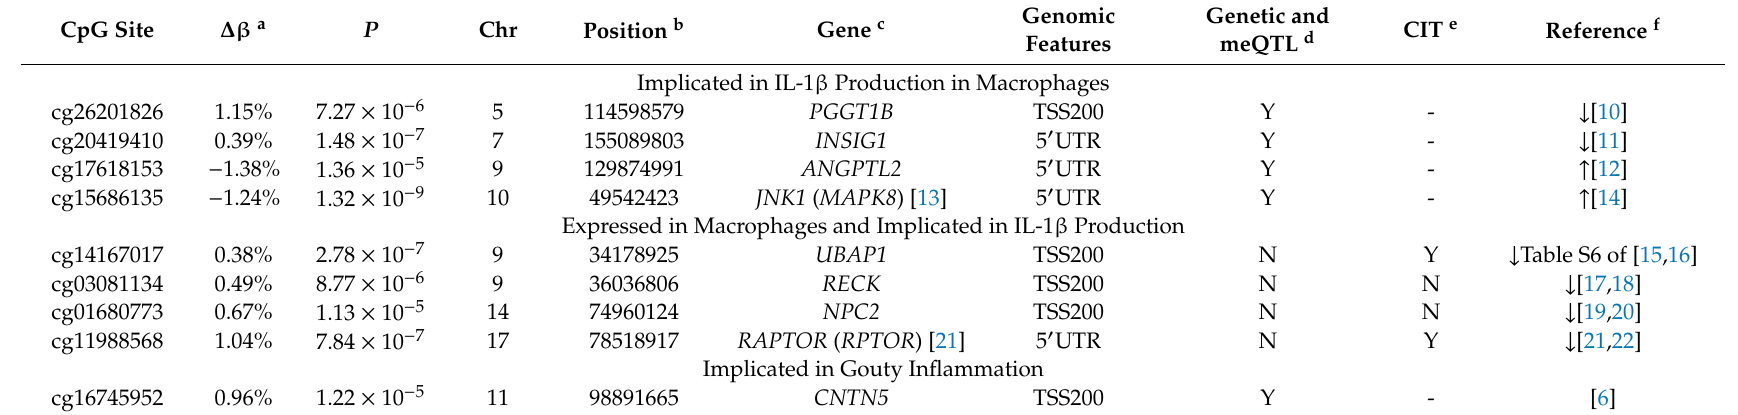
Table 1. Significant CpG sites that were mapped to genes implicated in IL-1 β production or gouty inflammation.